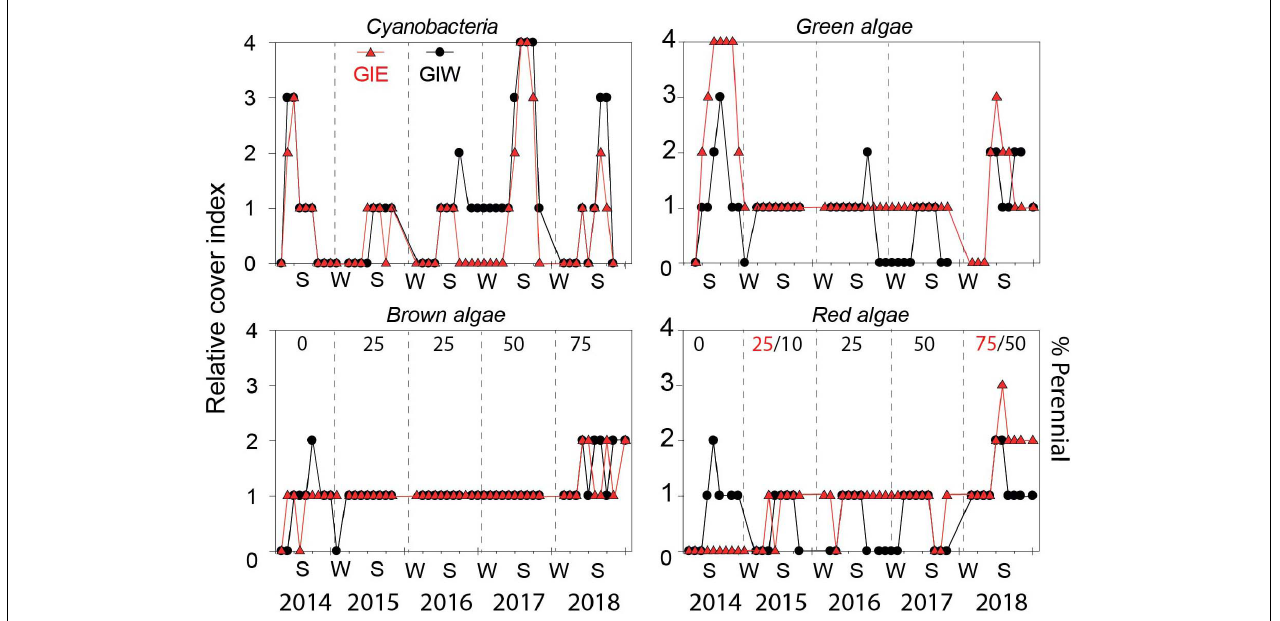
FIGURE 4 | Relative cover of cyanobacteria, green algae, brown algae, and red algae in Gyldensteen Coastal Lagoon from April 2014 to December 2018. The relative cover index is given as 0 (not present), 1 (present with 1–25% coverage), 2 (common with 26–50% coverage), 3 (abundant with 51–75% coverage), and 4 (dominant with 76–100% coverage). The percentage cover by perennial species is shown by numbers in black (red indicate GIE and black GIW only when stations differ) for brown and red algae. Lines and symbols given in red represent station GIE and in black represent station